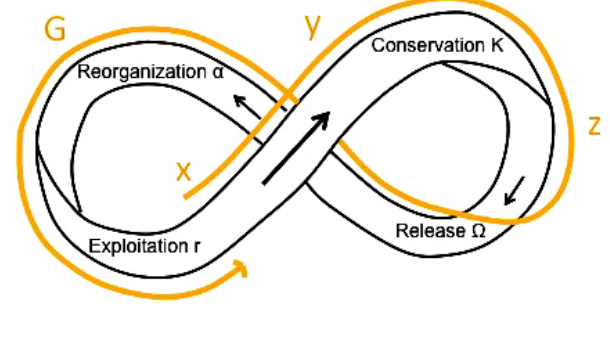
Fig. 6 . Overlay of our analysis onto the adaptive cycle. Our analysis suggests that the local SES is in the early r phase. The local SES had more than a century in the previous r phase (points x and y), collapsed as an agricultural landscape in the early 1990s (collapse from K, point z), was reorganizing between 1995 and 2005 (back loop, point G), and is in the early r phase as a multifunctional landscape. SES indicates social- ecological